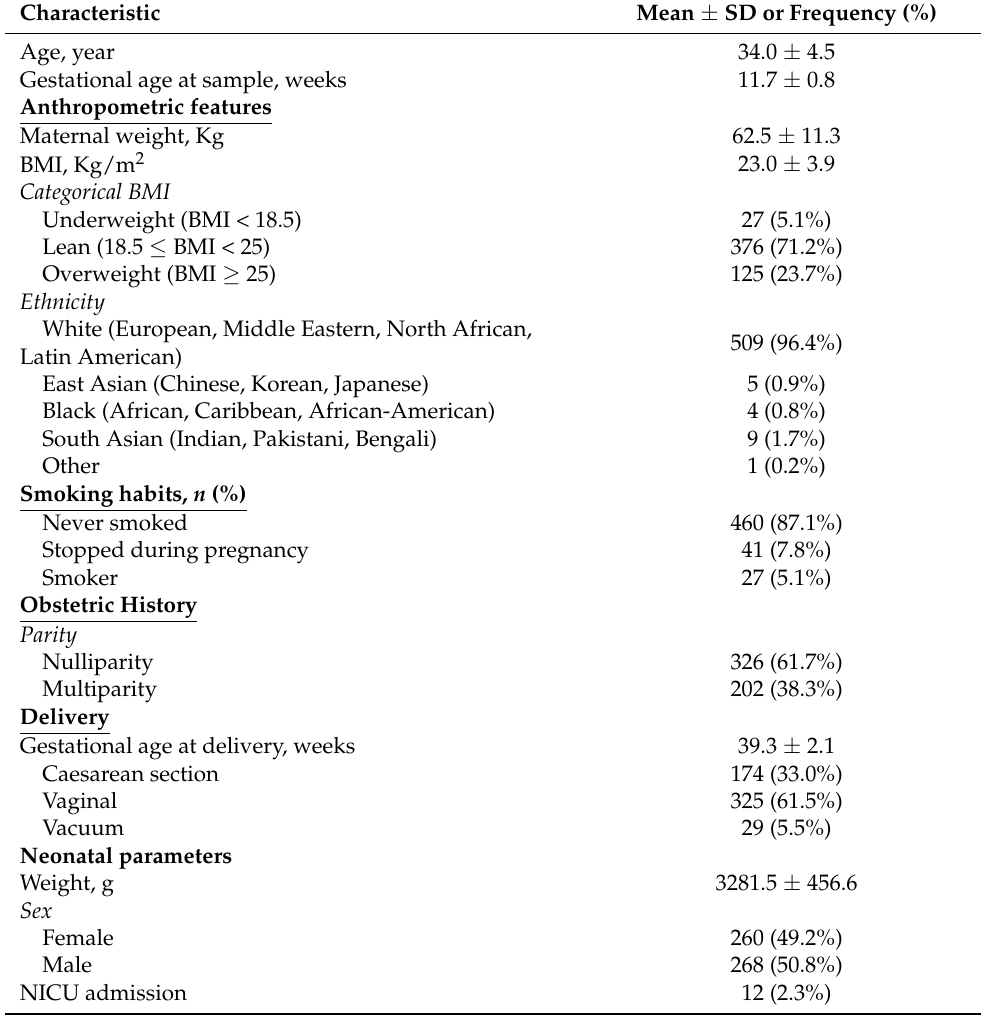
Table 1. Demographics and obstetric characteristics of 528 pregnant women and neonatal parameters.